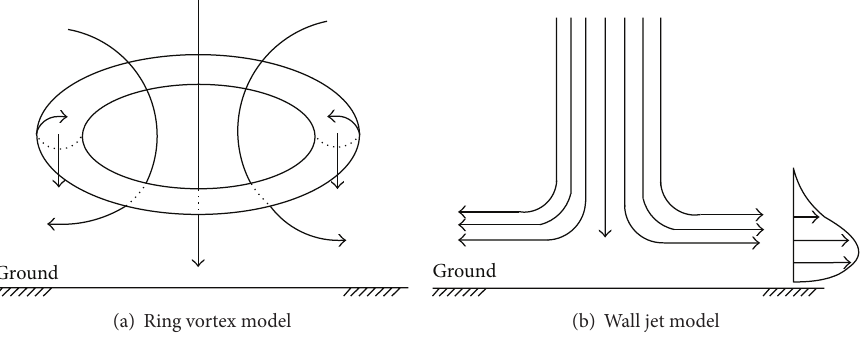
Figure 6: Typical models of downburst.